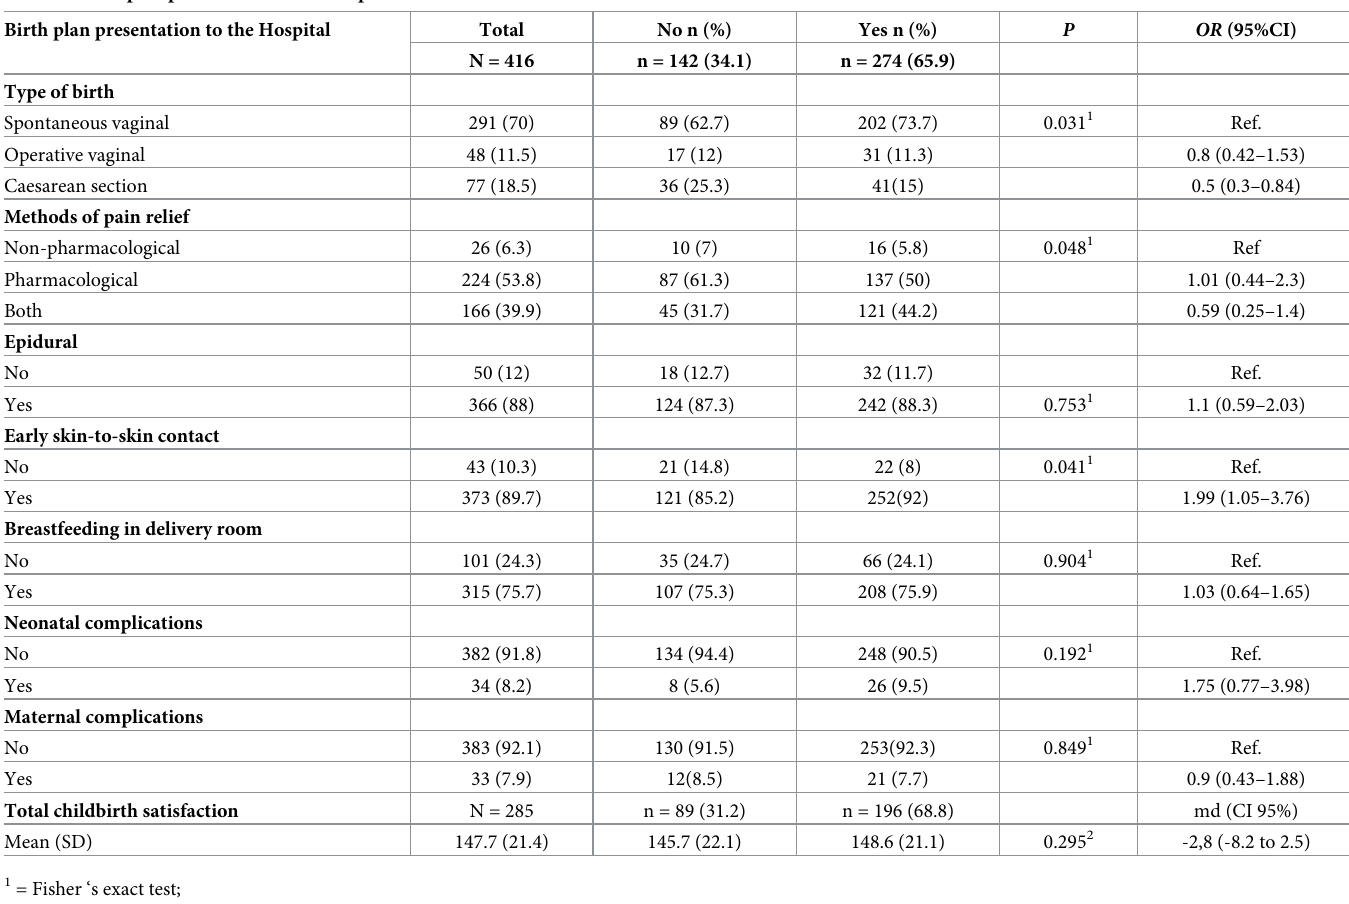
Table 6. Birth plan presentation to the hospital and relation to obstetric results and childbirth satisfaction. Birth plan presentation to the